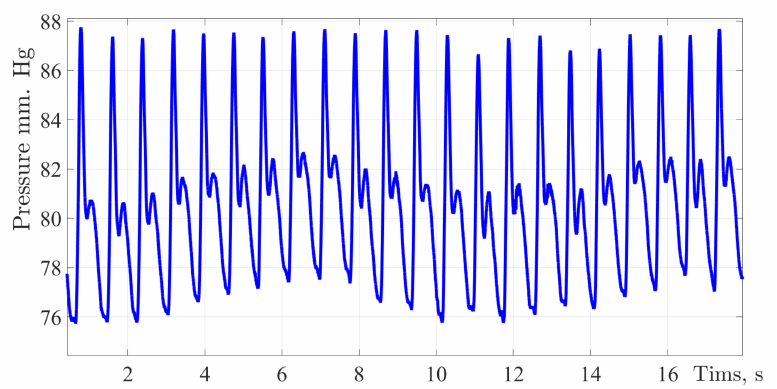
Figure 4. A typical fragment of a pulse wave signal recording obtained during the experiment process. Along the ordinate axis, the values of blood pressure in mmHg are deposited, and along the abscissa axis is the time with a sampling frequency of 512 Hz.